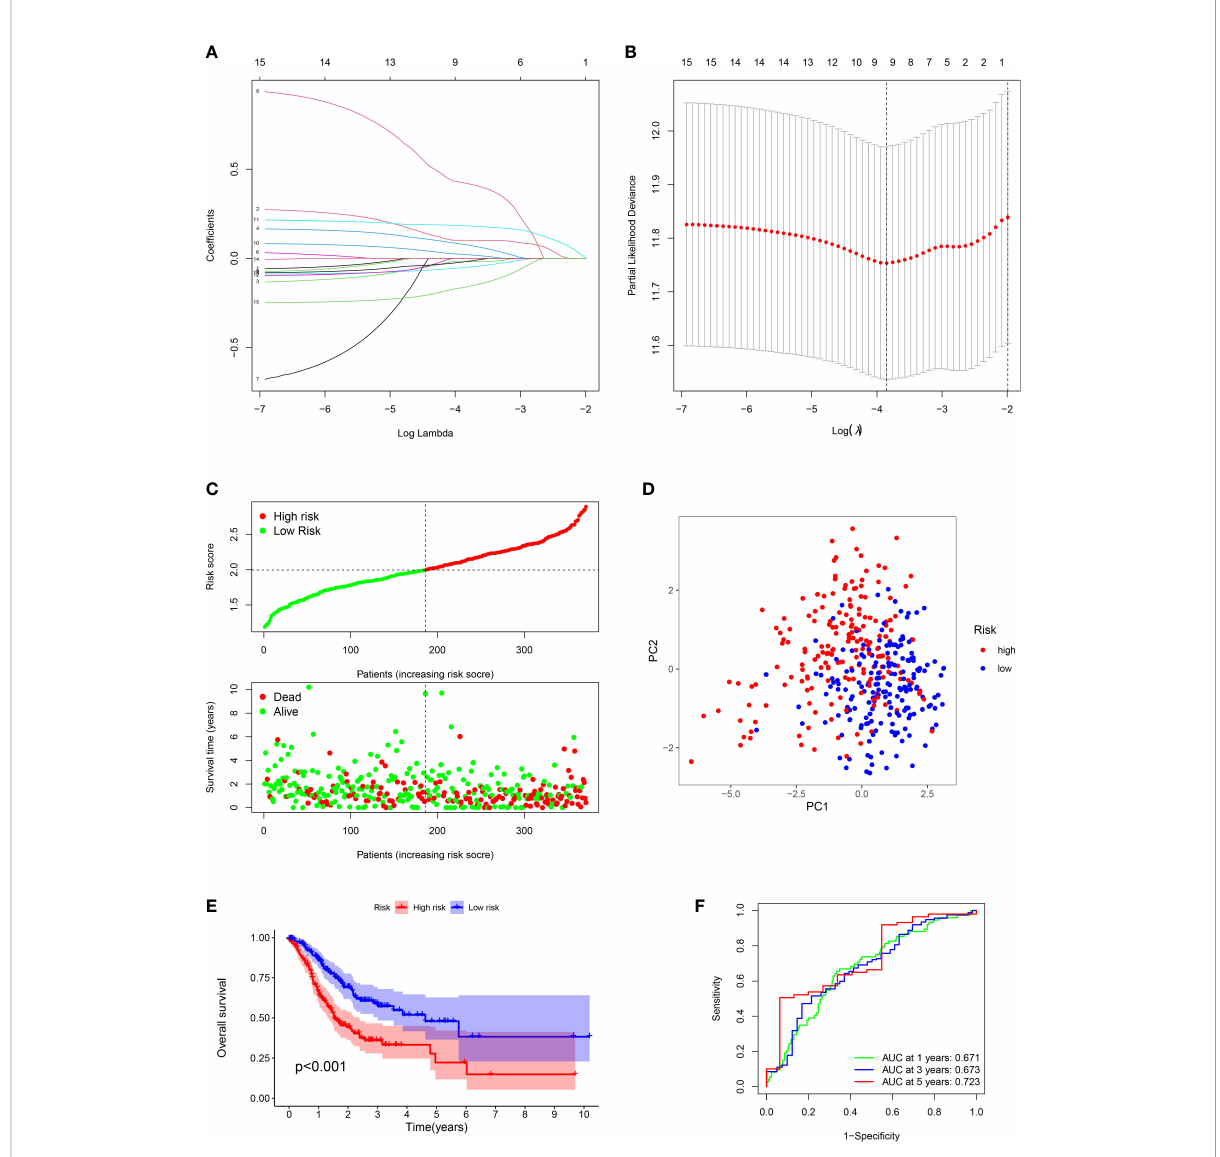
FIGURE 2 Construction of prognostic signature and evaluation of prognostic effect in TCGA dataset. (A, B) The LASSO analysis of the candidate genes. (C) Distribution of risk scores for each GC sample and survival time and status for each GC sample based on risk scores. (D) The PCA analysis of GC patients between high and low risk groups. (E) Survival differences between GC patients between high and low risk groups. (F) ROC analysis of GC